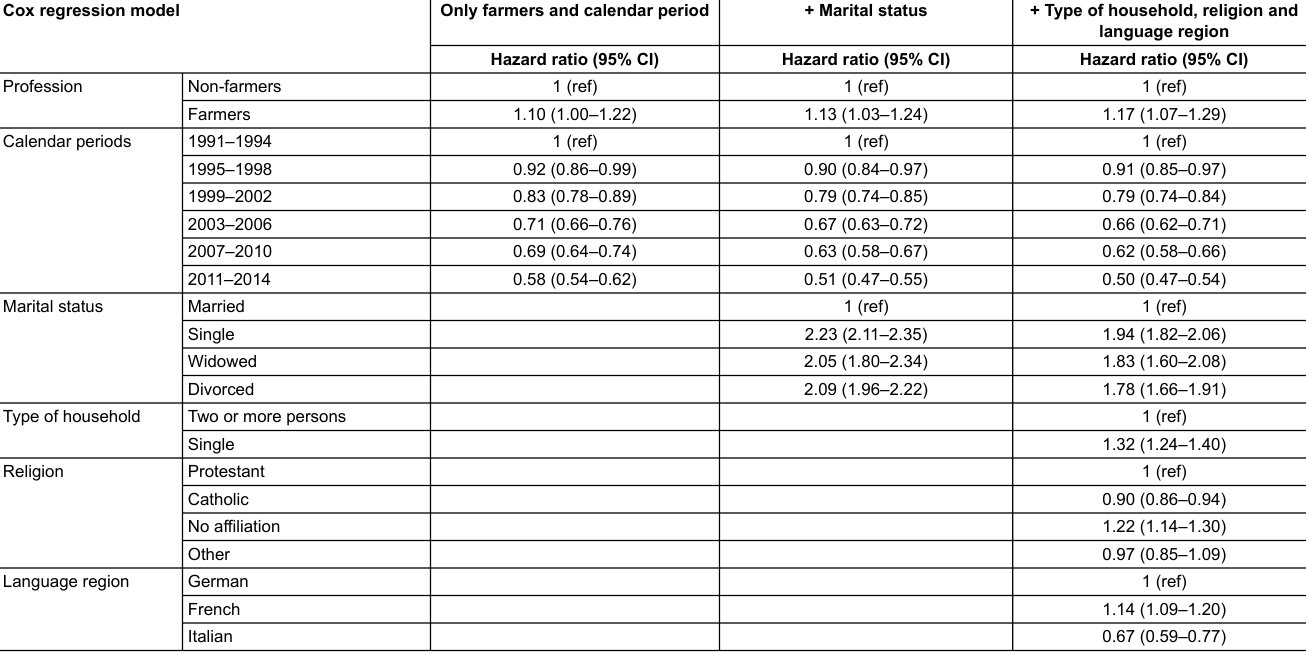
Table 3: Hazard ratios and 95% confidence intervals (CI)s for suicide from multivariable Cox regression models including profession, calendar period (Model 1), marital status (Model 2), and type of household, religion and language region (Model 3) as predictor variables. Cox regression model